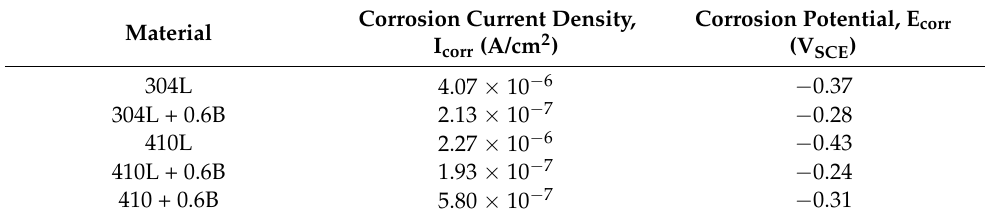
Table 4. Corrosion properties of five PM stainless